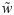
Numerical simulation of STDP-driven synaptic dynamics of a population of 120 excitatory synapses providing feed-forward input onto a single conductance based post-synaptic neuron (see e.g. Fig 3 and Methods for details).The pre-synaptic activity followed an inhomogeneous Poisson process with a time-varying intensity by eq (17), using N = 120, D = 10Sp/sec, A = 10Sp/sec, ν = 2π·10Hz. We simulated the temporally anti-symmetric exponential STDP rule (eq (4) with τ± = 20ms), with α = 1.1, μ = 0.1, using a learning rate constant λ = 5·10−4. (A and B) The synaptic weight profile w(φ, t) as a function of φ is shown for different times t = 0, 35,…80min by the different colors. The solid lines show the temporal average of w(φ, t) on the interval [t,t+1min]. (C) Traces showing the dynamics of all 120 synapses, each shown in a different color: black for the 60th synapse (φ60 = π), magenta for 120th synapse (φ120 = 2π), shades of blue for synapses 1–59 and shades of red for synapses 61–119. (D) The dynamics of the order parameter w˜ (eq (22)) shown in red (x100 scaled), and the oscillation amplitude of post-synaptic activity Apost (eq (6)) shown in black and measured in Sp/sec, binned in time-bins of 1 minute. (E) The dynamics of the order parameter ψ (eq (22)) shown in red (calculated in time-bins of 1 sec), and the oscillation phase of post-synaptic activity φpost (calculated in time-bins of 1 min). (F) The distribution of synaptic weights of all 120 synapses, calculated using the second half of the simulation (after convergence to a limit cycle solution). The vertical cyan line denotes the mean value of the distribution. (G) The characteristic shape of the propagating wave, calculated from synaptic weights during the second half of the simulation. Error bars depict the standard error of the mean (calculated from measurements binned at 1sec during the second half of the simulation). The calculation of φpost was obtained using time-bins of 1 min. The vertical magenta line shows the mean phase difference between pre- and post- synaptic activity.